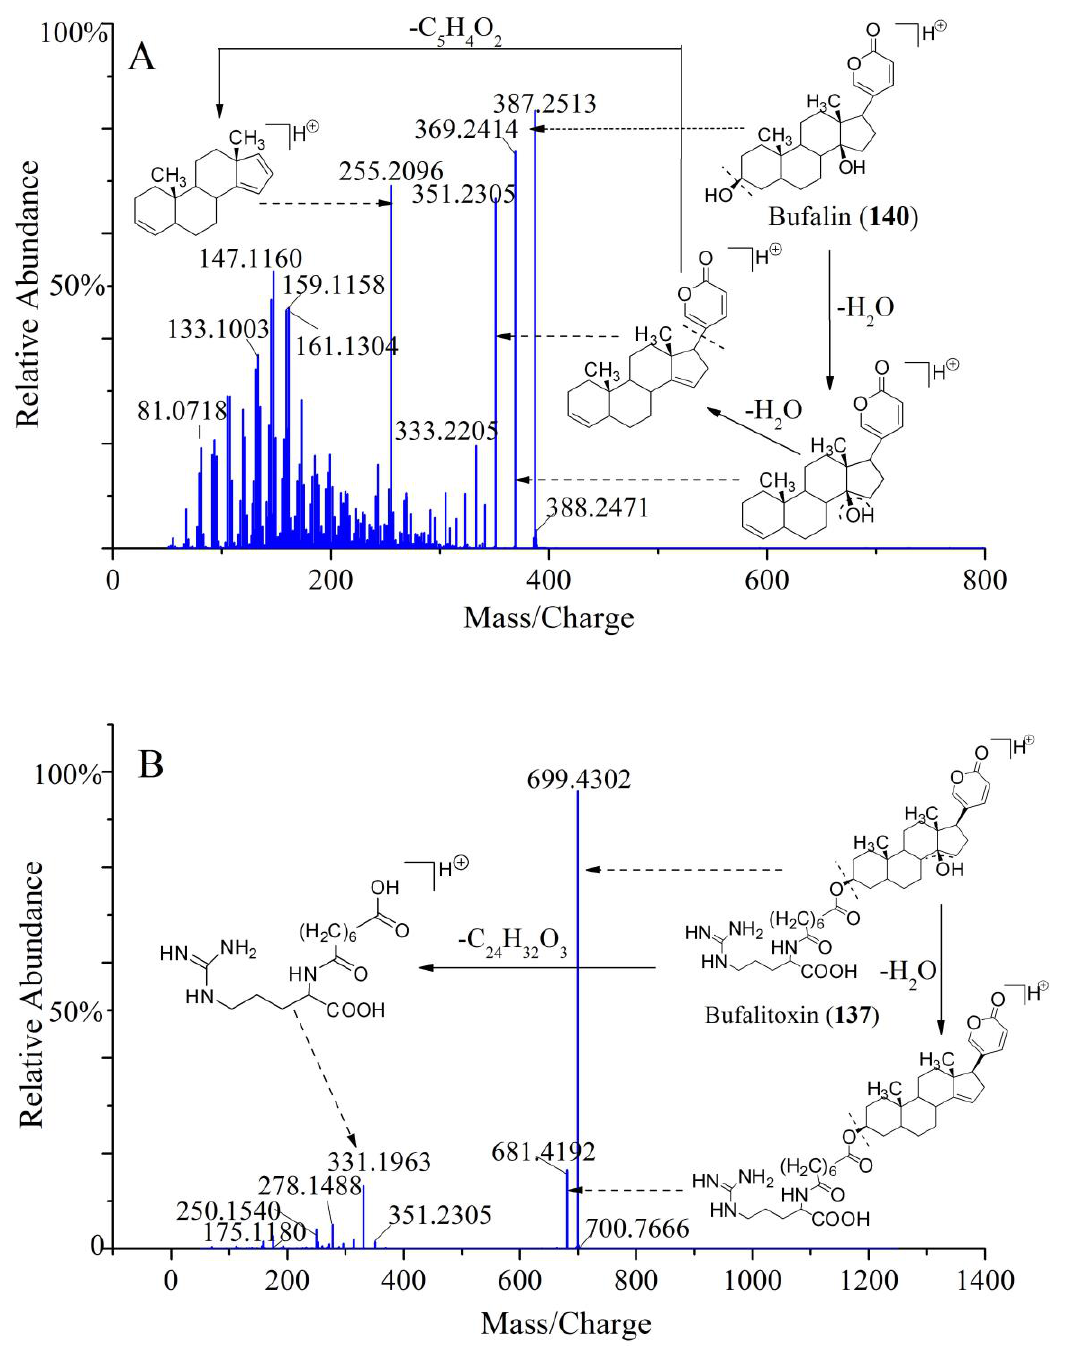
Figure 5. The fragmentation pathways and the typical MS / MS spectrums of bufalin ( A ) and bufalitoxin ( B ).